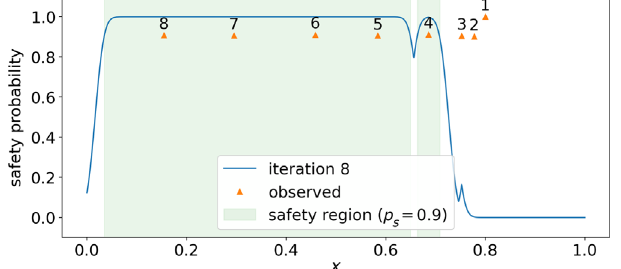
FIG. 12. Snapshot of the safety probability along the viable range at the end of 1D safety exploration. The safety probability curve is calculated based on the alternative drift model with the given observations. Orange triangles denote the observations, and the order of sampling is denoted by the number on top of each observation. The blue curve is the calculated safety probability and the green shaded area shows the safety region with the safety ¼ 0 . 9 . probability threshold p s